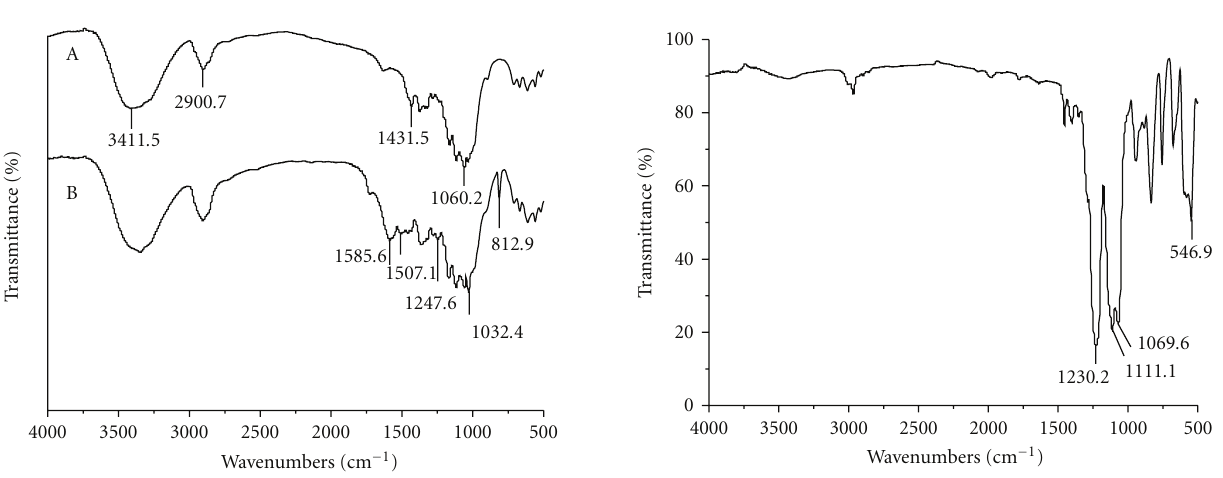
Figure 1: FT-IR spectra of the untreated (A) and the treated cotton (B).